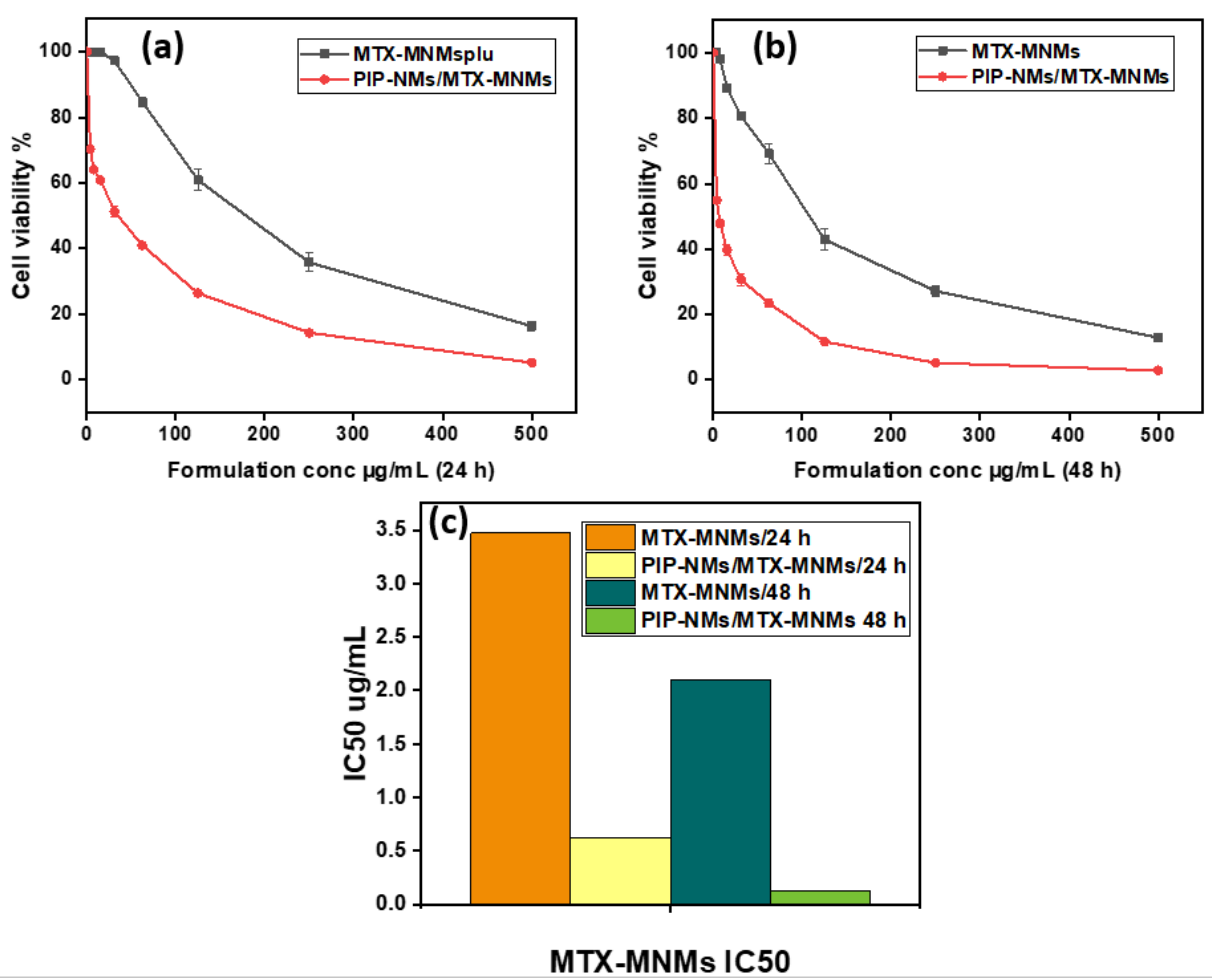
Figure 5. ( a , b ) The cytotoxicity test on MCF-7 cells at 24 h ( a ) and 48 h ( b ) of MTX-MNMs individually and the mixture of PIP-NMs/MTX-MNMs using half PIP-NMs IC 50 , and ( c ) the IC 50 values from the cytotoxicity assay of MTX-MNMs only and the mixture of PIP-NMs/MTX-MNMs at 24 and 48 h, respectively.